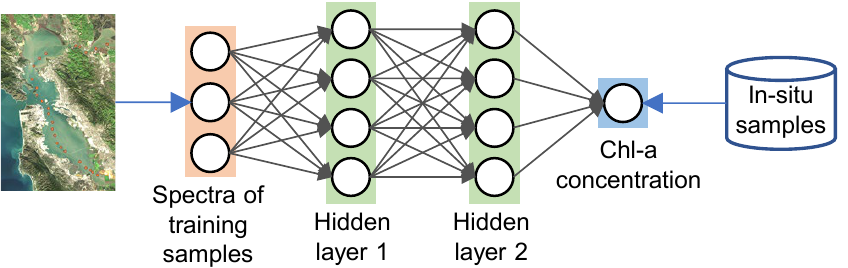
Figure 6. Schematic representation of training NN model for Chl-a retrieval in San Francisco Bay.